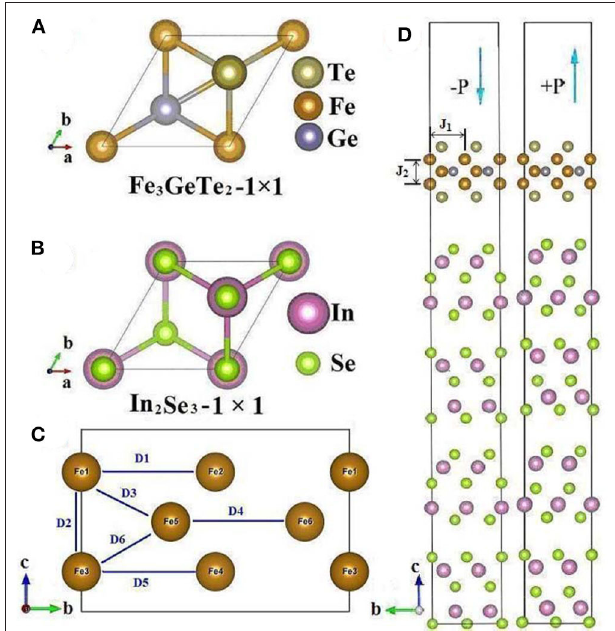
FIGURE 1 | The crystal structures of the van der Waals Fe 3 GeTe 2 /In 2 Se 3 HS. The top view of the bulk Fe 3 GeTe 2 (A) and In 2 Se 3 compounds (B) ; the side view of the coefficients of Dzyaloshinskii-Moriya (DM) interaction in the Fe 3 GeTe 2 monolayer, only the Fe atoms are shown in the structure (C) ; and the side view of the Fe 3 GeTe 2 /In 2 Se 3 HSs with the ferroelectric polarization P ) (D) . These two HSs are built along directed downward (– P ) and upward ( + √ 2 in-plane supercells. the (001) direction within the √ 2 ×